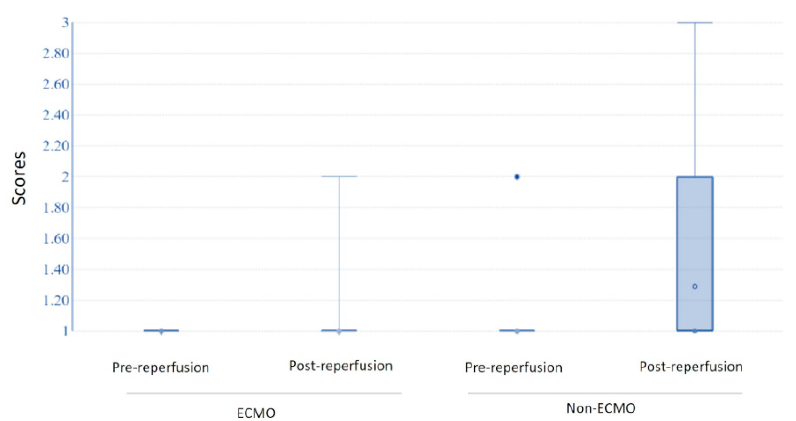
Figure 5. Explanatory figures for the ECMO and non-ECMO patients. Leukocyte margination ( A , B hematoxylin and eosin staining, 40× original magnification, red arrowhead), iNOS expression ( C , D immunohistochemistry, 40× original magnification), and apoptotic cells (dark nuclei, red arrows) ( E , F tunel assay, 40× original magnification) are more evident in non-ECMO than in ECMO patients.